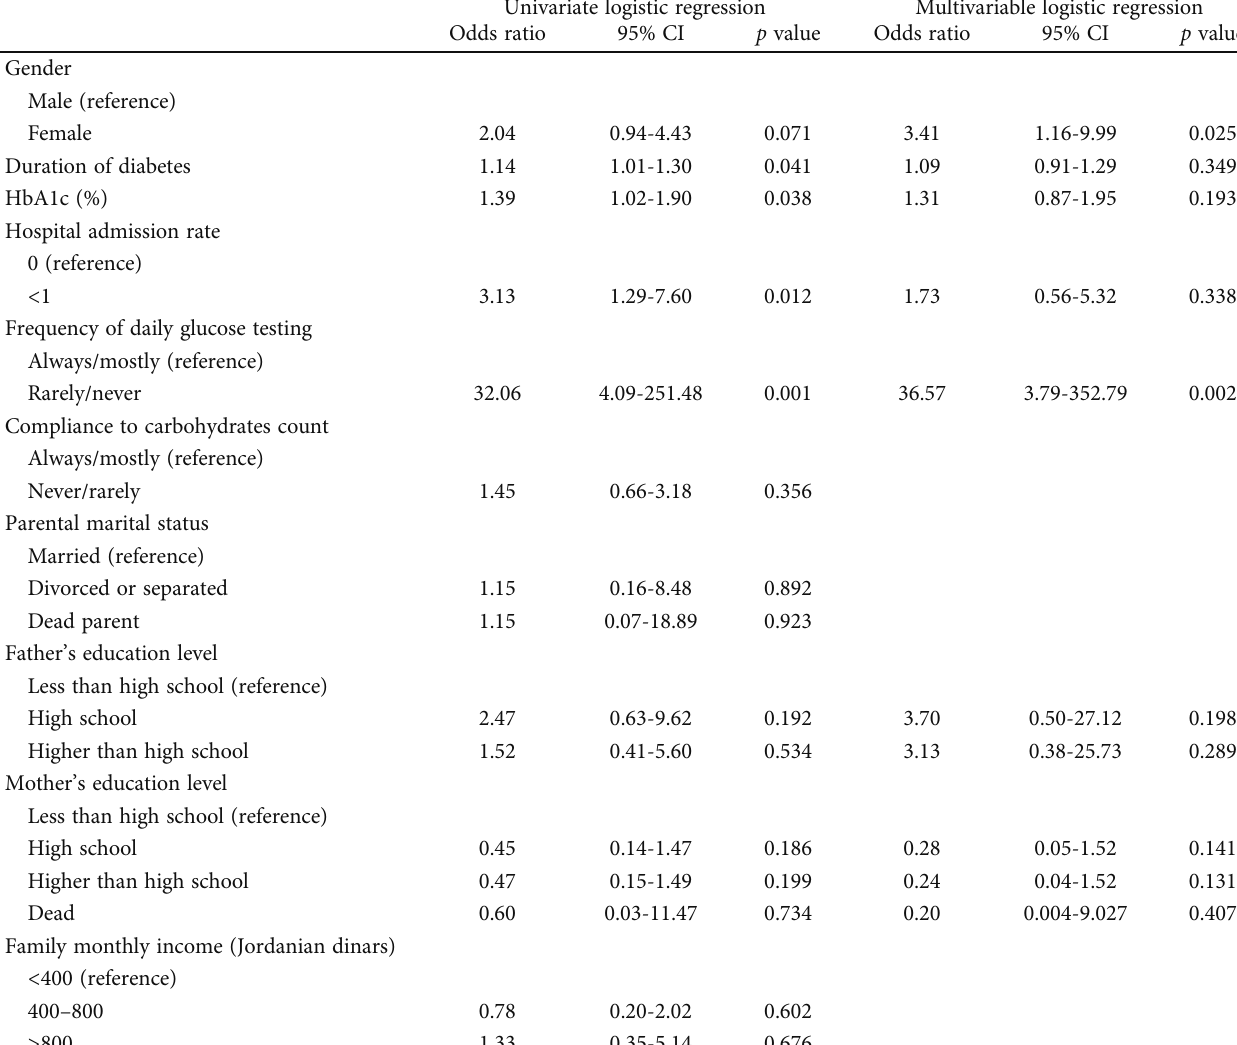
Table 3: Univariate and multivariable logistic regression analysis for possible predictors of